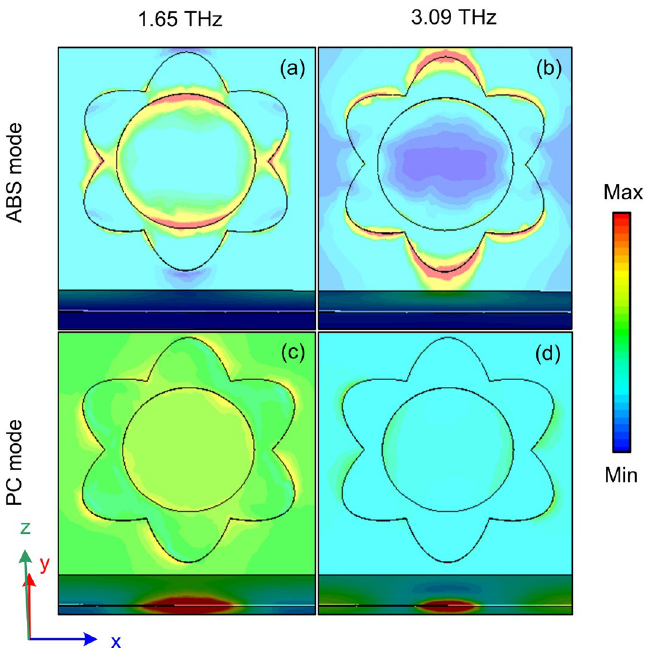
Figure 4. Performance of RMSs for ABS and PC